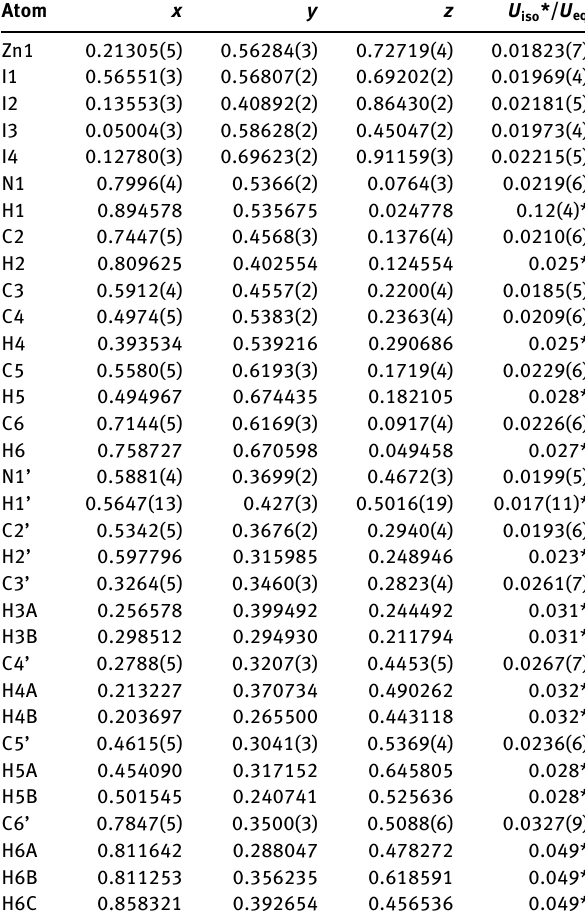
Table 2: Fractional atomic coordinates and isotropic or equivalent isotropic displacement parameters (Å 2